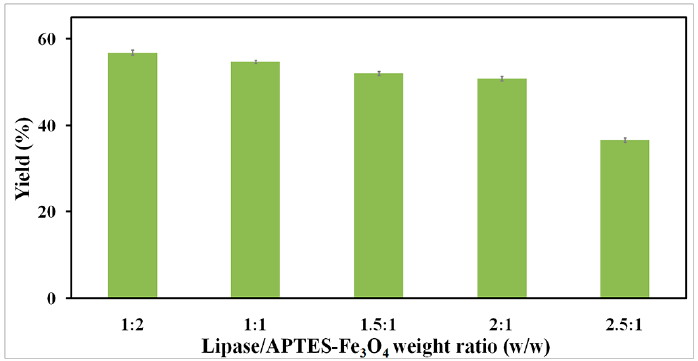
Figure 7. Effect of glutaraldehyde concentration on the on the activities of magnetic RML CLEAs.